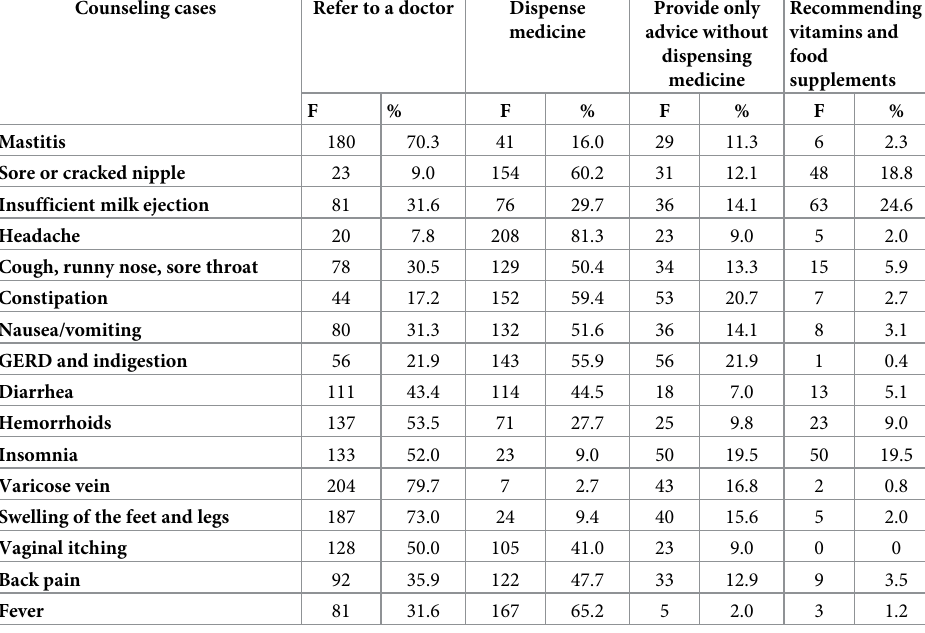
Table 2. Number and percentage of the questions on knowledge regarding OTC medications counseling during breast-feeding (n =